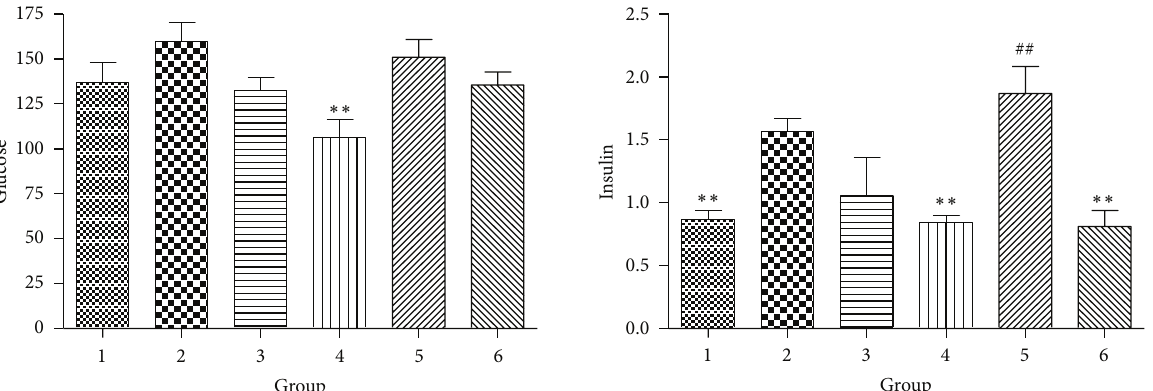
Figure 3: Levels of serum glucose and insulin ( ∗ 𝑃 < 0.05 compared with Group 2. ∗∗ 𝑃 < 0.01 compared with Group 2; # 𝑃 < 0.05 compared with Group 1. ## 𝑃 < 0.01 compared with Group 1).